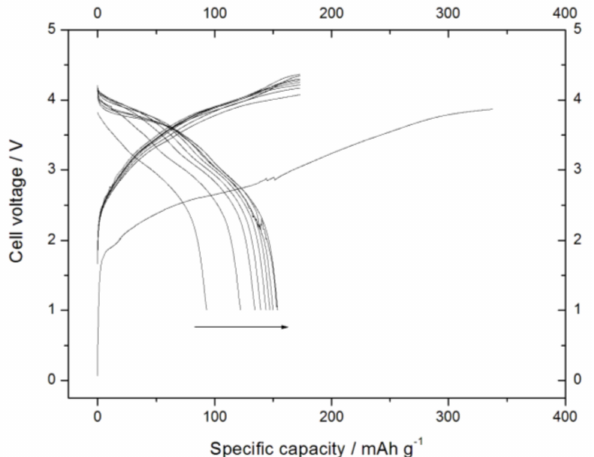
Figure 12. Voltage profiles recorded during the first 10 charge/discharge cycles for the Sn-RGO/Na 1.0 Li 0.2 Ni 0.25 Mn 0.75 O δ SIB. The cycles were conducted at 0.088 mA between 4.4 V and 1.0 V. The arrow indicates the progression of the